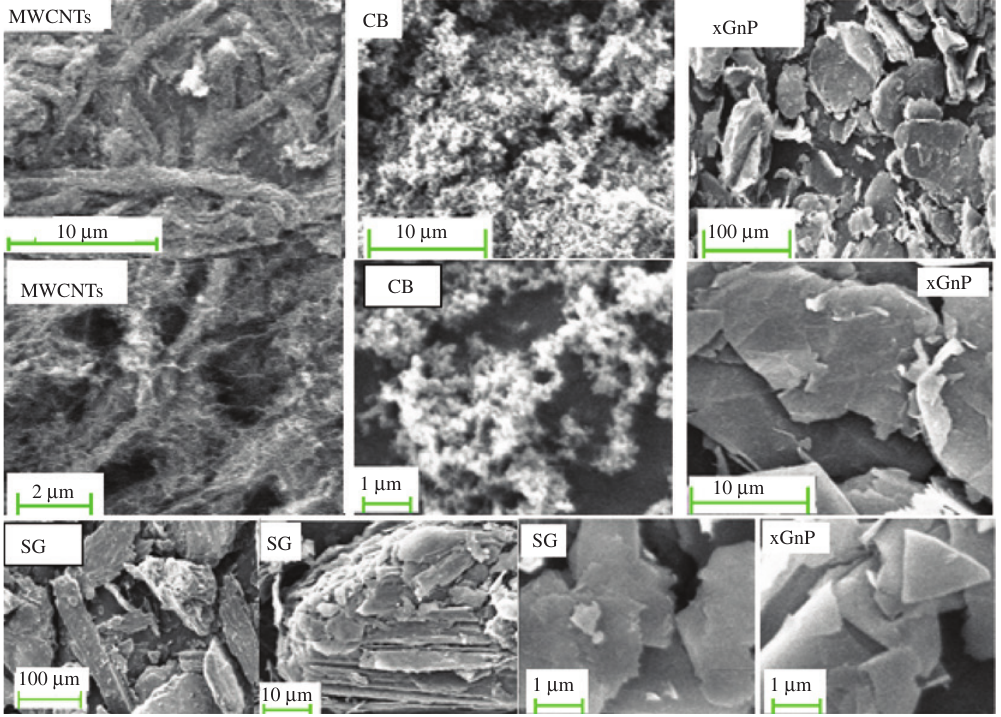
Figure 9: The SEM micrographs of the MWCNTs, xGnP, CB and SG at different